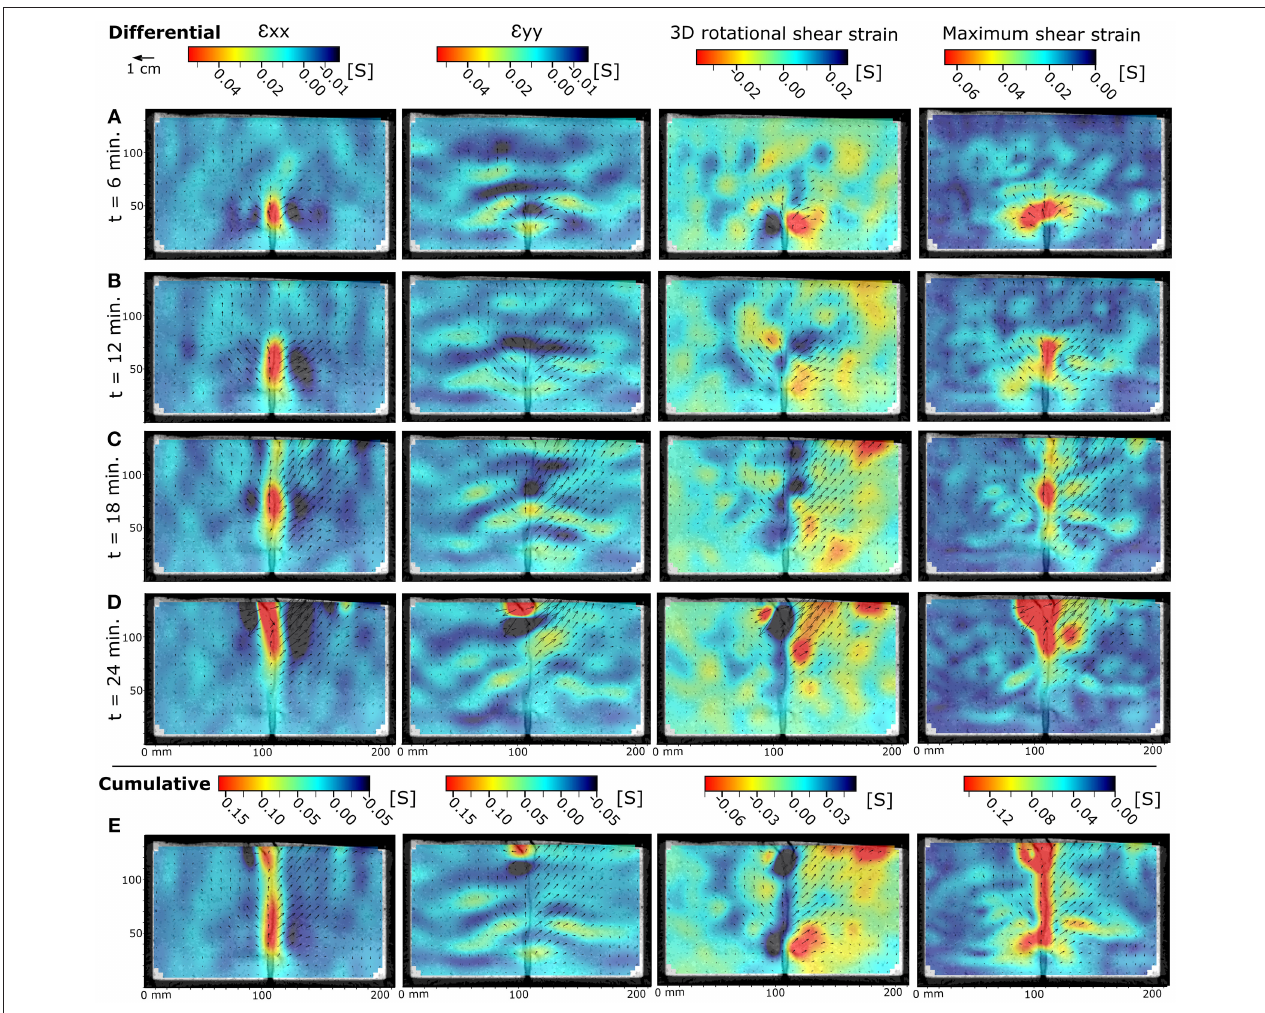
FIGURE 11 | DVC results for differential (A–D) and cumulative (E) host material deformation induced by a dike intrusion in a 50:50 wt% sand: plaster mixture (SPCTIN04 in Table 2 )—arrows indicate magnitude and orientation of calculated displacement vectors: (Left column) Horizontal (longitudinal) strain, shortening is negative/blue; (Central left column) Vertical (axial) strain, shortening is negative/blue; (Central right column) Horizontal rotational shear strain around the z-axis, anticlockwise rotation is positive/blue; (Right column) Maximum shear